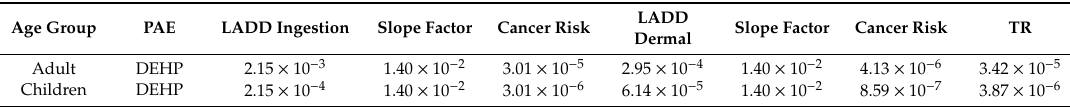
Table 6. Risk values of carcinogenic